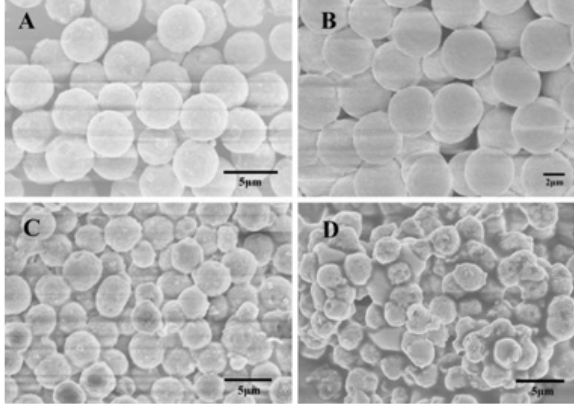
Figure 12: FT-IR spectra for unmodified and functionalized silica